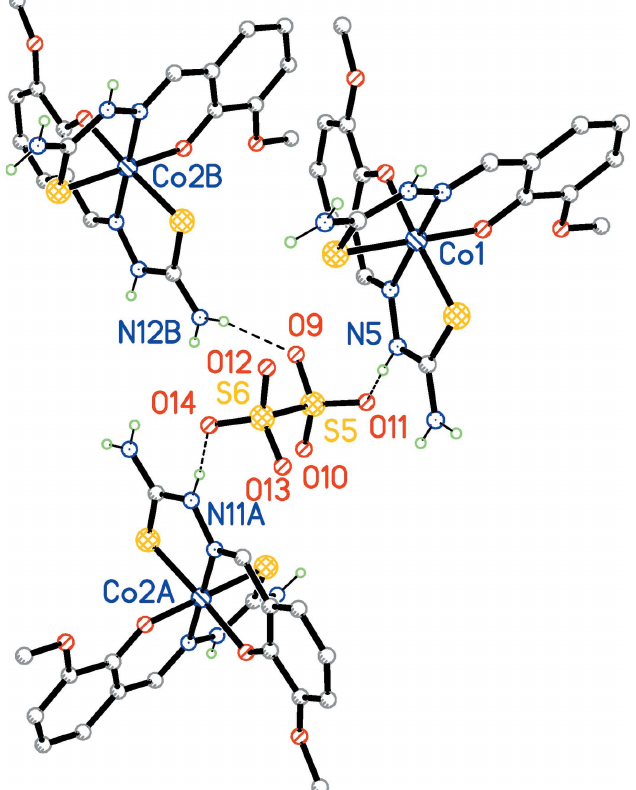
Figure 3 A fragment of the packing of the title compound demonstrating the N– H (cid:2)(cid:2)(cid:2) O contacts that link three complex cations and an S 2 O 62 (cid:3) anion as an hydrogen-bond acceptor. Hydrogen bonds are shown as dashed lines. Methanol solvate molecules bonded to S 2 O 62 (cid:3) by O—H (cid:2)(cid:2)(cid:2) O hydrogen bonds, dimethyformamide solvent molecules and C-bound hydrogen atoms are omitted for